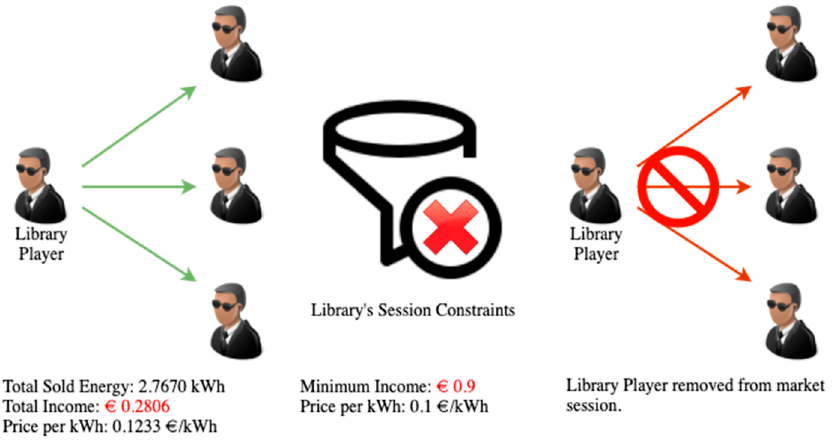
Figure 3. Library player session results after applying session constraints.